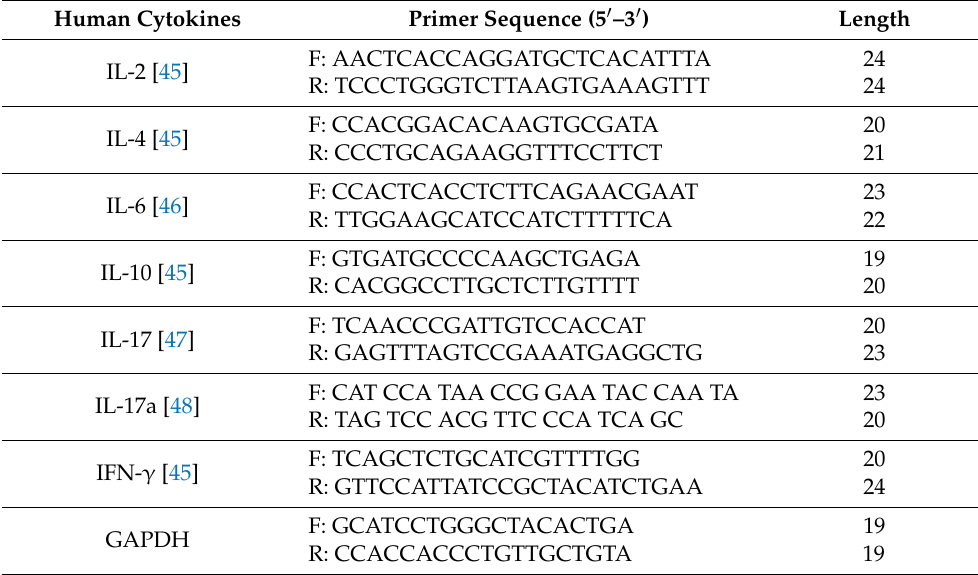
Table 2. Primer sequence of the target genes of human oral squamous cell carcinoma tissues.